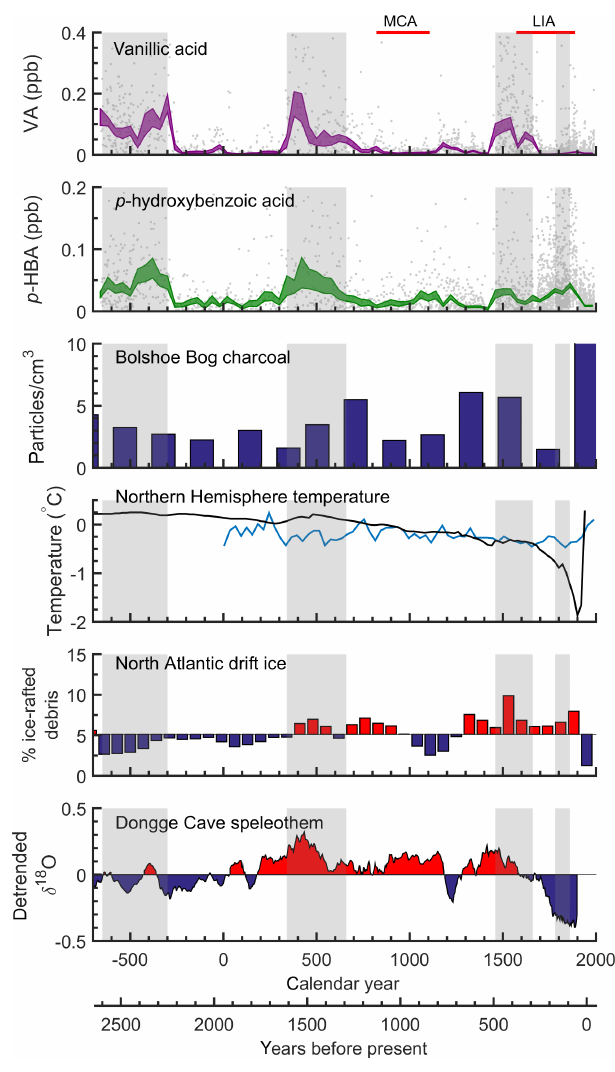
Figure 8. Comparison of the timing of aromatic acid signals in the Akademii Nauk ice core over the past 3000 years compared to other climate-related proxy records. From top: 40-year bin- averaged (violet fill is 1 standard error of log transform) Akademii Nauk ice core vanillic acid measurements from this study, 40- year bin-averaged (green fill is 1 standard error of log transform) Akademii Nauk ice core para -hydroxybenzoic acid measurements from this study, Bolshoe bog charcoal record (Blarquez et al., 2014), 30-year medians of domain areas of PAGES 2k tempera- ture reconstructions (blue; PAGES 2k Consortium, 2013) and 20- year means of zonal 30–90 ◦ N stacked temperature reconstruction (black; Marcott et al., 2013), North Atlantic ice-rafted debris indi- cating Bond events (blue<mean; red>mean) (Bond et al., 2001), and smoothed Dongge Cave climate record from Asia showing changes in the monsoon using a moving average (blue<0, red>0; window size = 15) (Wang et al., 2005). The vertical gray shaded ar- eas are periods of elevated vanillic acid and para -hydroxybenzoic acid, identified as periods when the bin-averaged data are in the upper quartile of the transformed dataset. The red lines are the Me- dieval Climate Anomaly (MCA) and the Little Ice Age